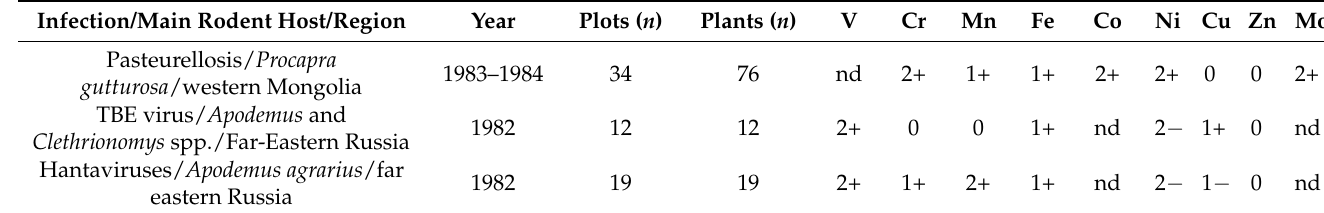
Categories of concentrations for Table 4: 0: Concentration of a particular element was significantly different between plague and control plots (<20%). 1+: Concentration of a particular element was higher in plague plots (20–100%). 2+: Concentration of a particular element was much higher in plague plots (>200%). 1 − : Concentration of a particular element was lower in plague plots (20–100%). 2 − : Concentration of a particular element was much lower in plague plots (>200%). nd: No